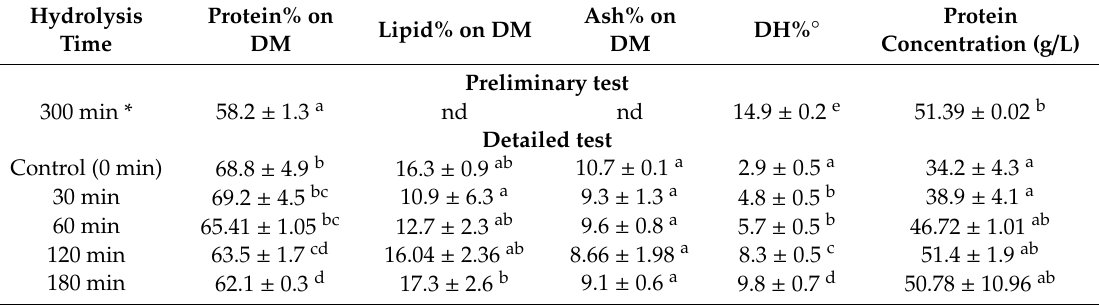
Table 1. Bulk composition of hydrolysates and freeze-dried control samples collected at di ff erent time points during the enzymatic hydrolysis with information about DH% and protein